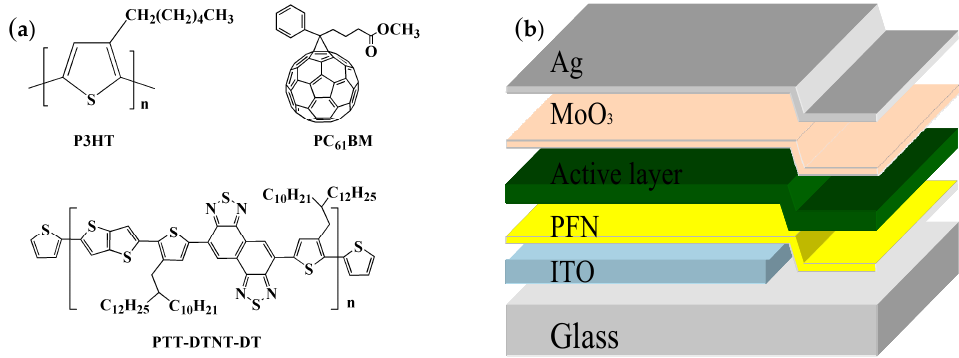
Figure 1. ( a ) Chemical structures of materials in active layer; ( b ) Device configuration of ternary OPVs.